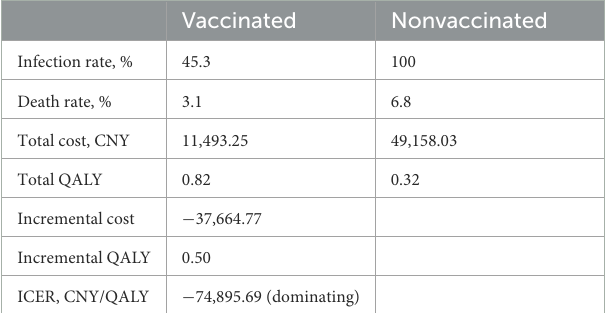
TABLE 2 Clinical outcomes and cost-effectiveness results in base